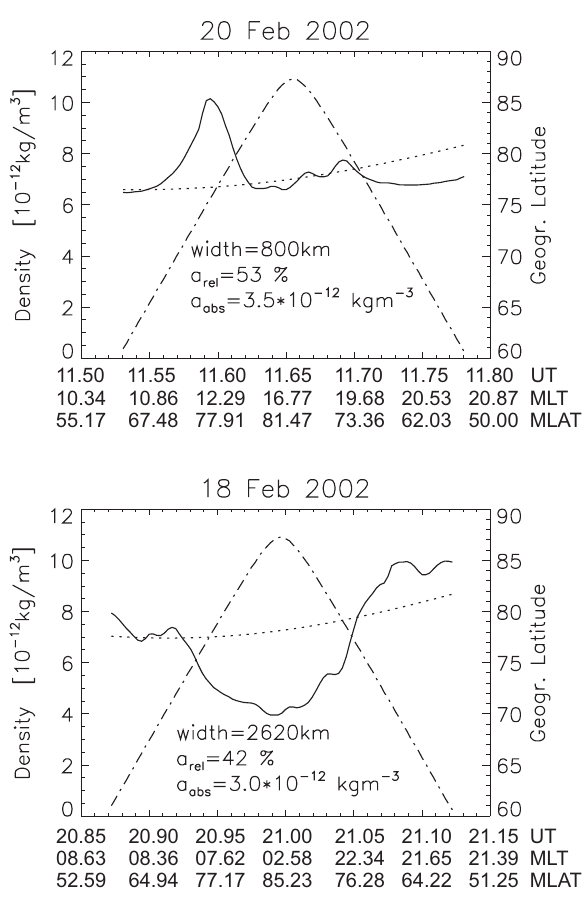
Fig. 3. Two examples of large-amplitude maxima and minima (solid line). The dotted line is the average undisturbed density ρ av , the dash-dotted line indicates the geographic latitude. The legend gives the absolute and relative density amplitude and the